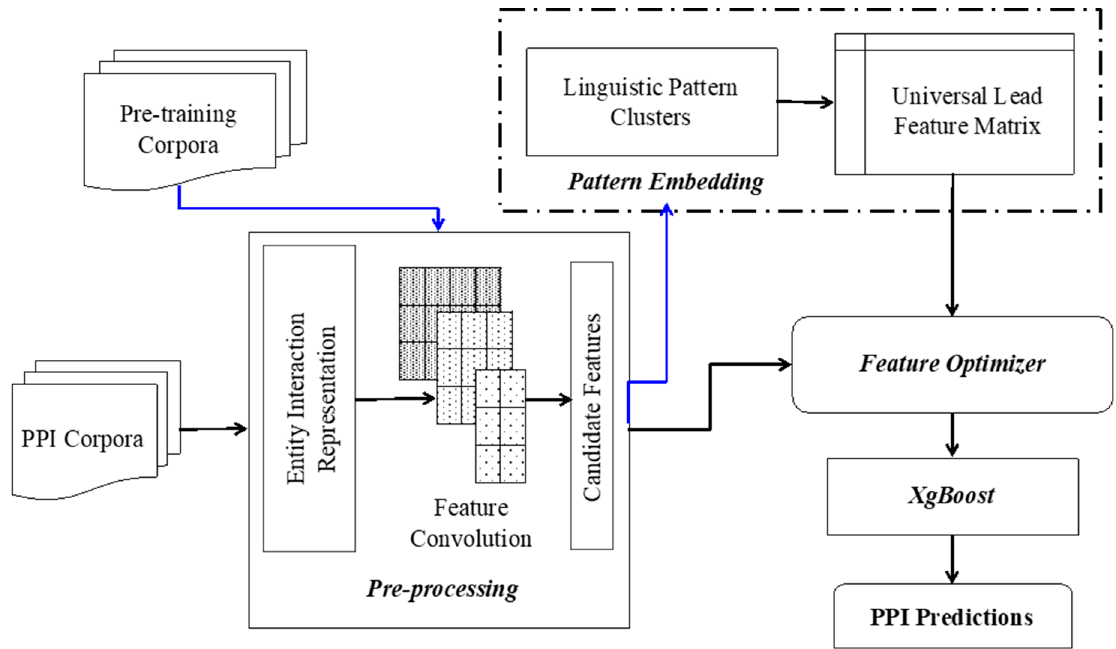
Figure 1. System architecture for